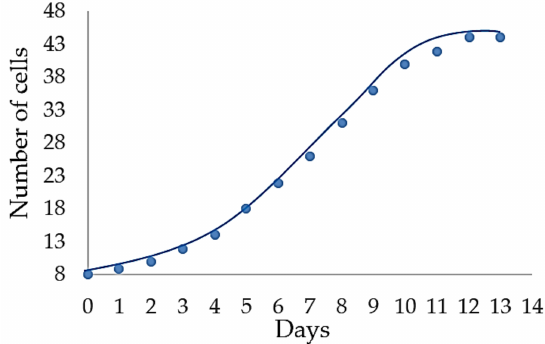
Figure 9. Characteristics of E. gracilis population growth on-chip: approximately parabolic dependence on time, consistent with the literature data